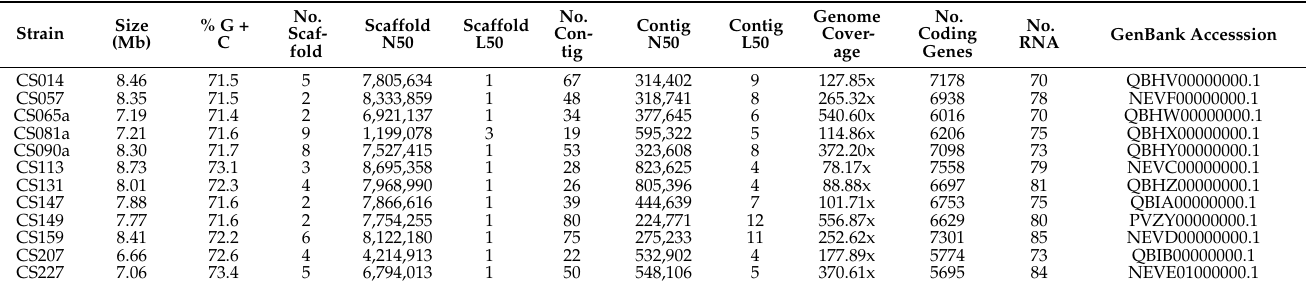
Table 1. Genomic assembly data